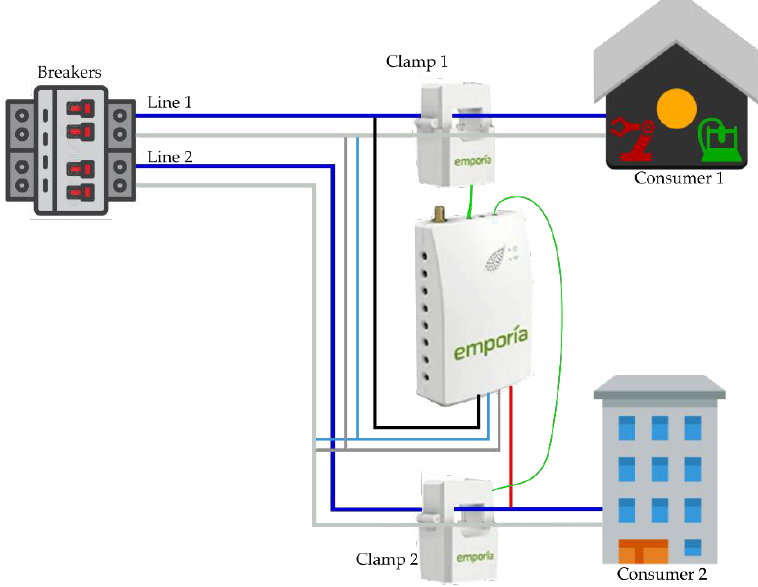
Figure 9. Gen 2 Vue Energy Monitor electrical connections.